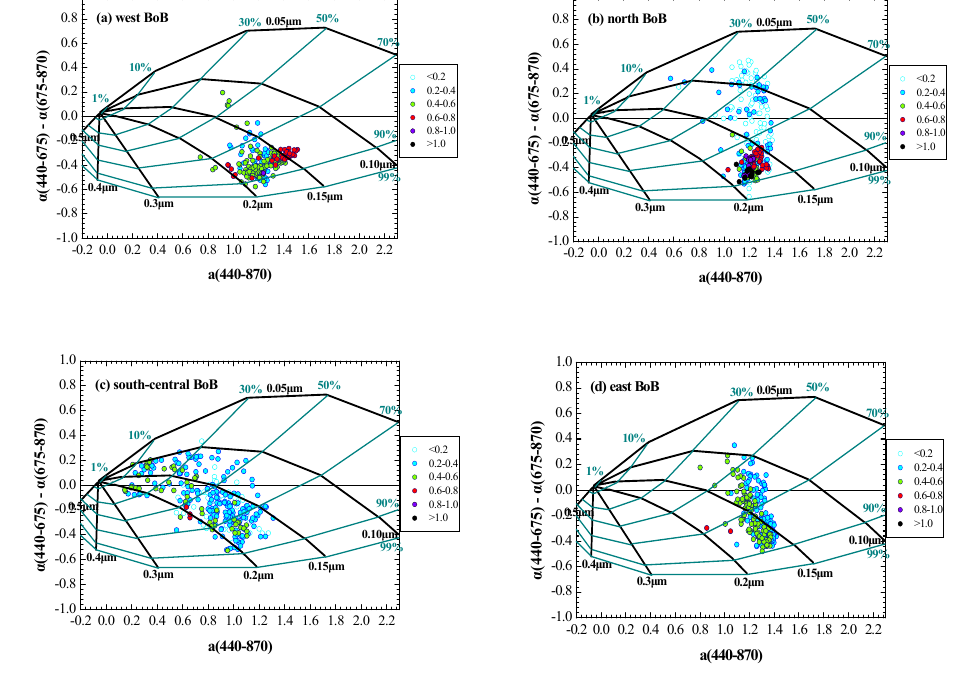
Fig. 10. Same as in Fig. 9, but for the four BoB sub-regions.